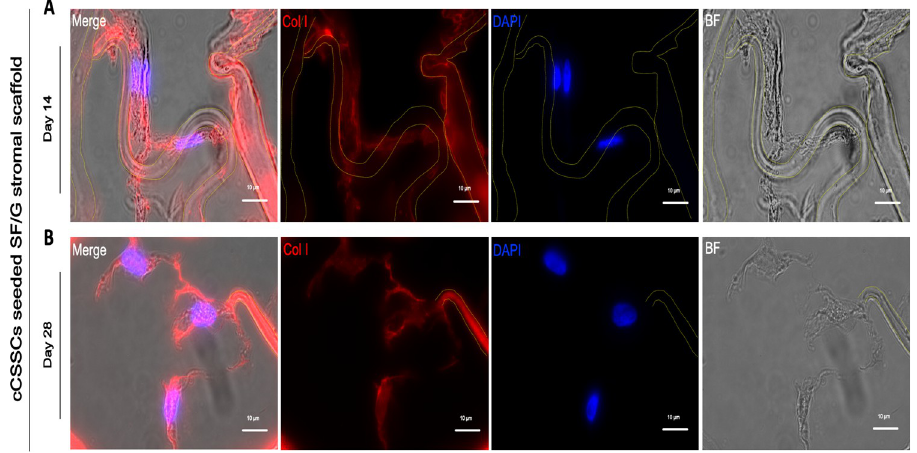
Fig 8. Immunofluorescent staining of collagen I. Differentiated keratocytes express collagen I at extracellular compartment at day 14 (A) and day 28 (B). Immunofluorescences image with 1000x magnification. Scaffolds are marginated by yellow border. Scale bars present 10 μ m (A,